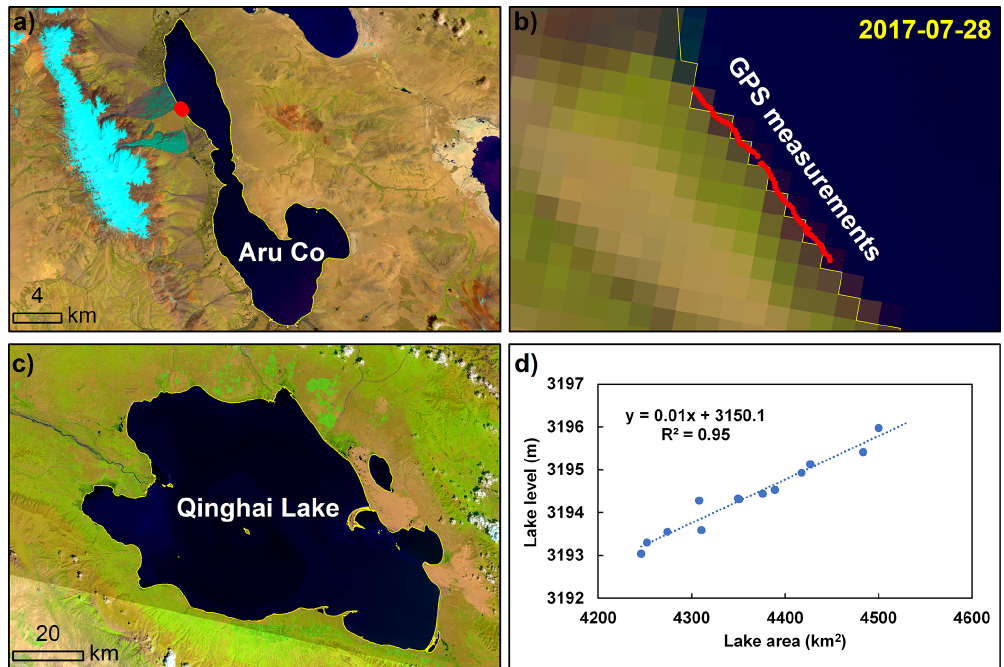
Figure 5. Validation of delineated lake boundaries from GPS measurements and comparison with lake level, with background of Landsat images from USGS. (a) Location of GPS measurements points for Aru Co. (b) Distribution of GPS measurements points along the water boundary of Aru Co. (c) Boundary of Qinghai Lake from Landsat image in 2020. (d) Comparison between lake area and water level from gauging station for Qinghai Lake between 1976 and 2019. Locations of Aru Co and Qinghai Lake on the QTP are shown in Fig.